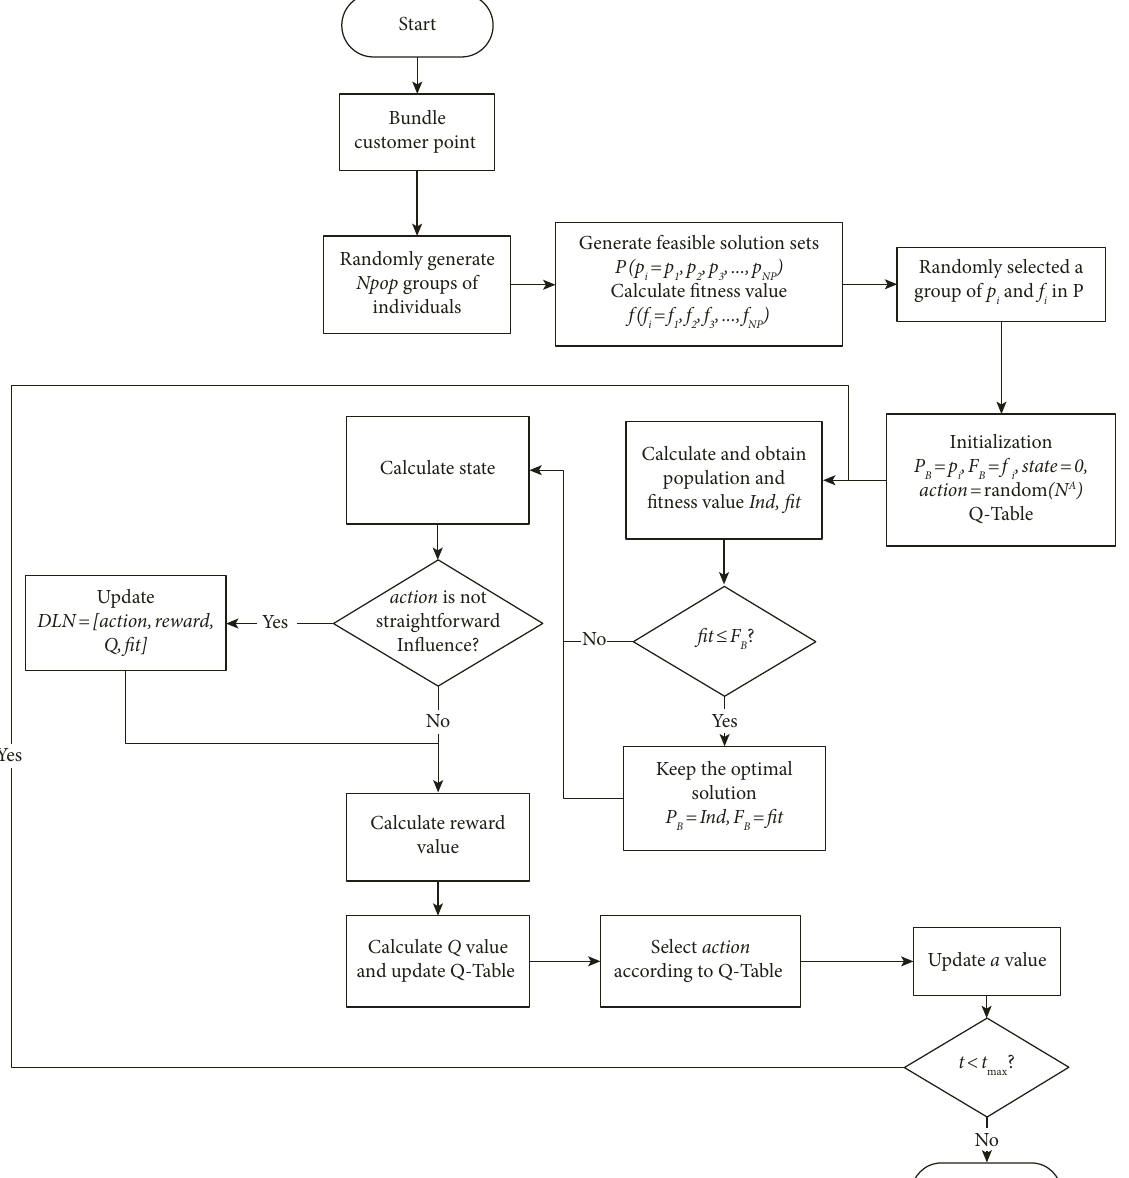
Figure 2: Algorithm